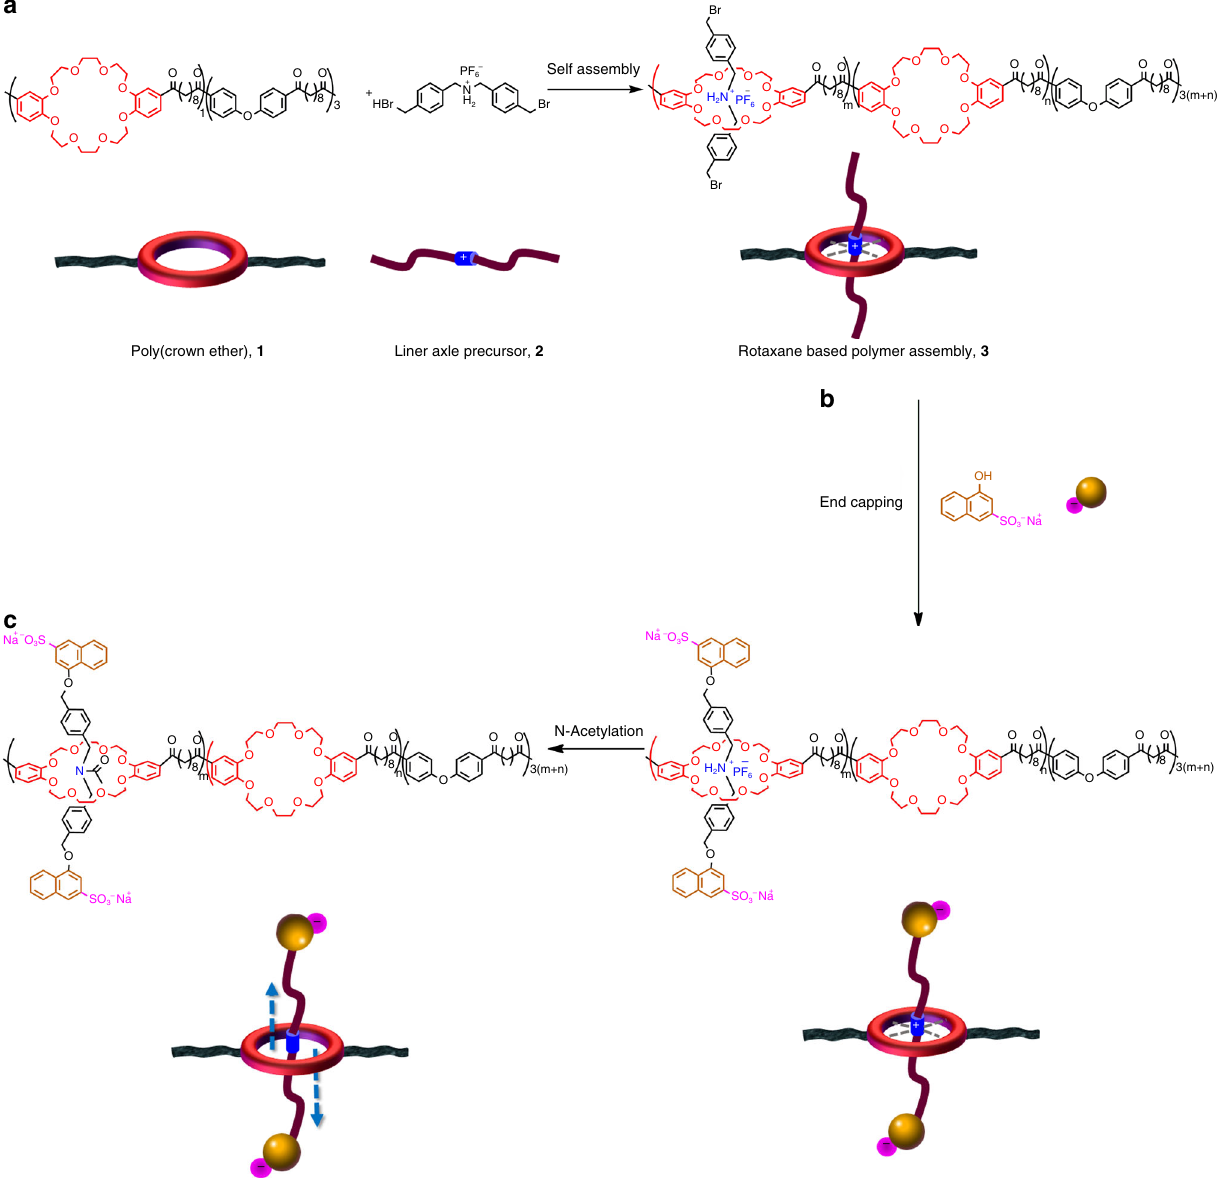
Fig. 1 Synthesis of a rotaxane based polymer entity. a Poly(Crown ether), 1 , was synthesized via polyacylation and the host – guest interaction between 1 and 2 results in rotaxane based polymer assembly, 3 . b End-capping of 3 was performed to prevent the diffusion loss of movable axles, leading to 4 . c N-acetylation of 4 leads to the target polymer, 5 , having axles with enhanced mobility. For synthetic details and characterizations, see Supplementary Figs. 1 –